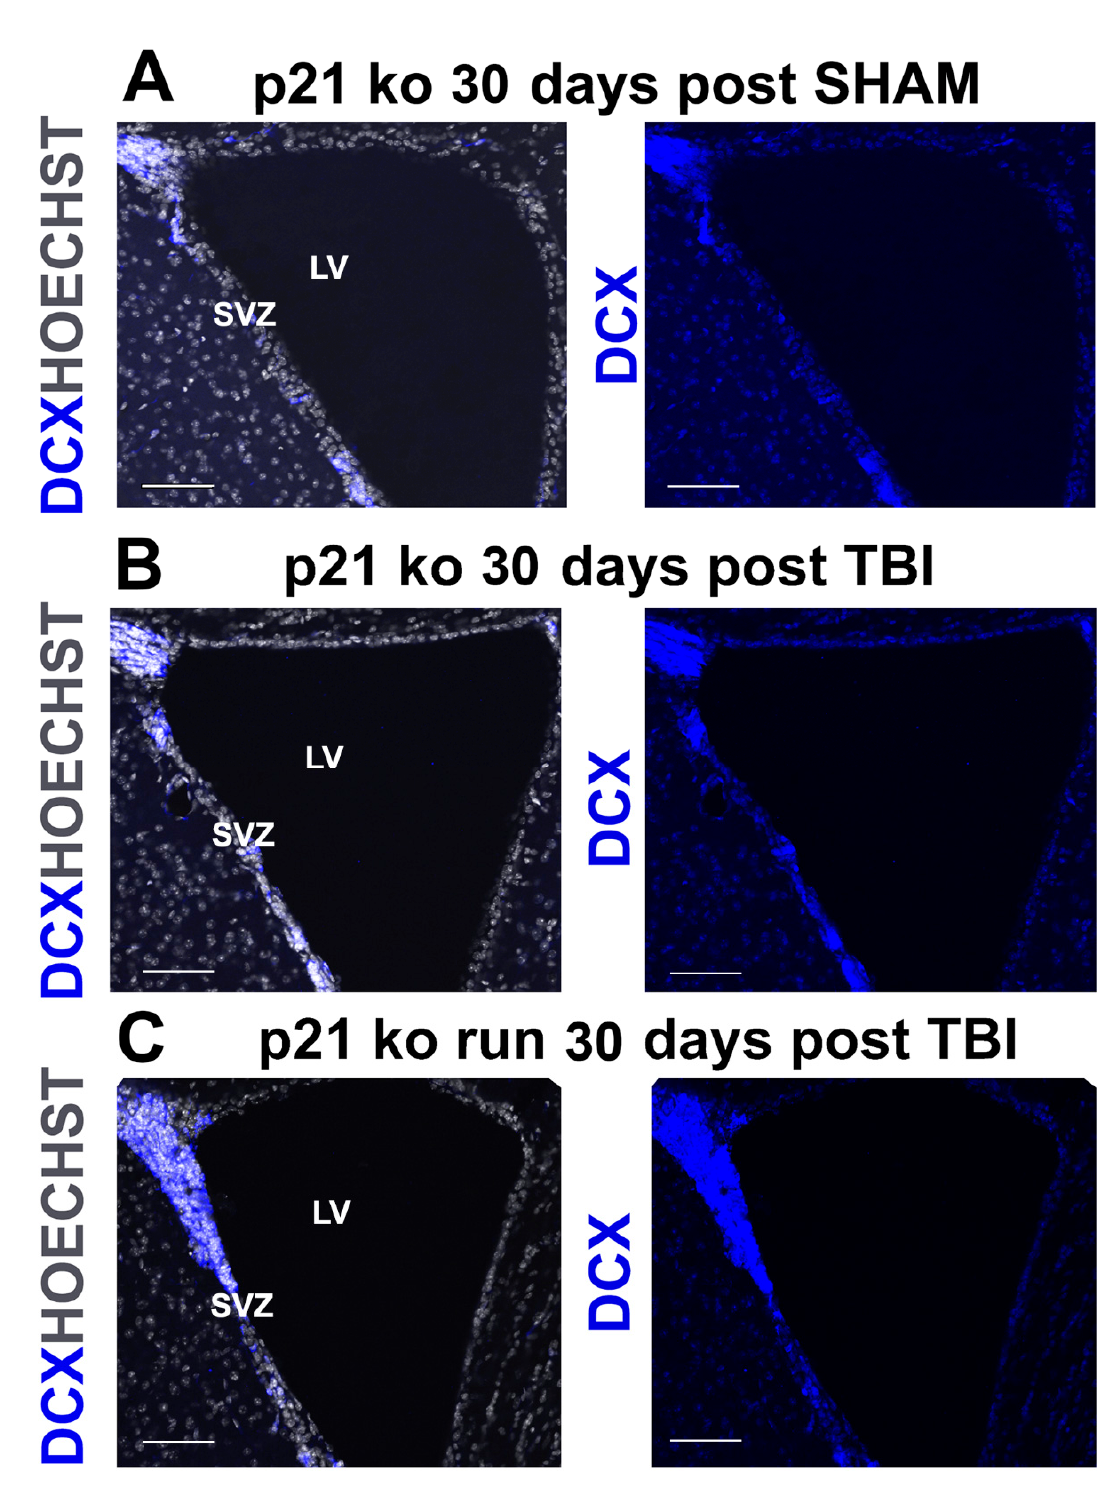
Figure 4. ( A – C ). Increase in DCX+ cells in the KO RUN TBI group. Confocal representative micro- graphs show the increased number of DCX + cells in the KO RUN TBI mice ( C ), in comparison with the KO SHAM ( A ) and KO TBI ( B ) mice, 30 days after TBI. Magnification = 20 × . Scale bar = 100 µ m. SVZ = subventricular zone. LV = lateral